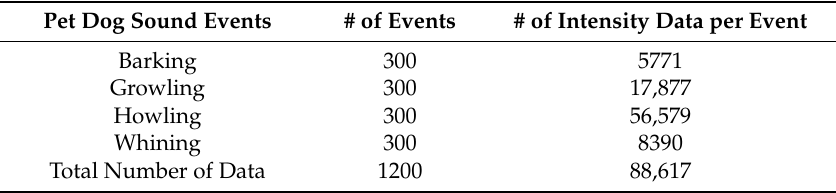
Table 6. Number of data of four pet dog sound events.